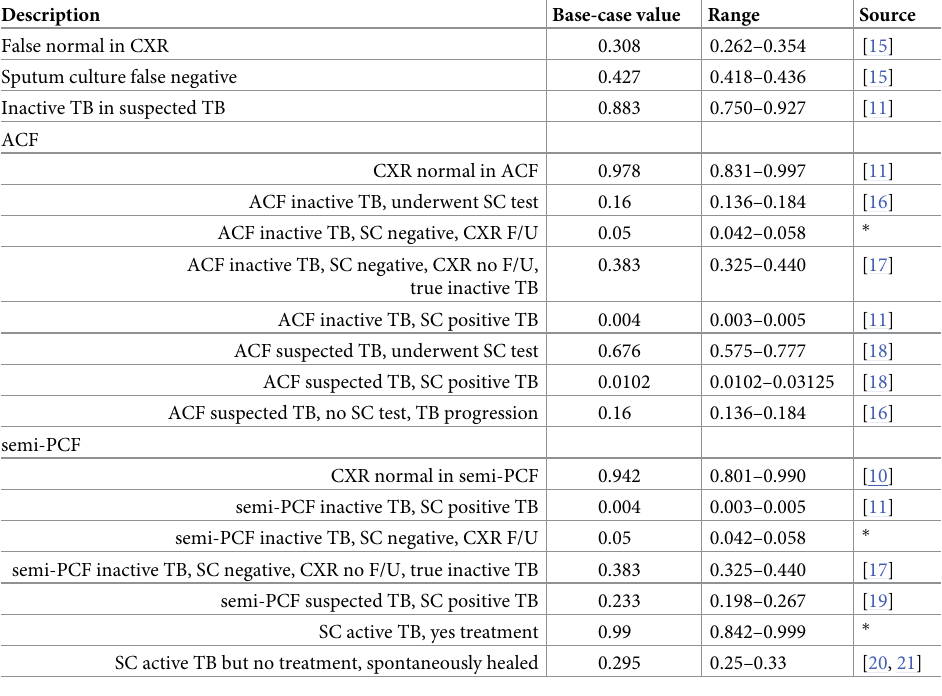
Table 3. Base-case value, range, and description of variables used in cost-effectiveness analyses for ACF with CXR and semi-PCF with CXR.